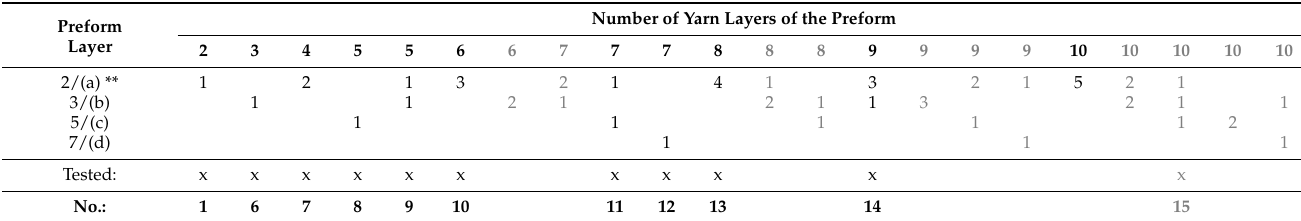
Table 2. Test series numbering and assignment. Table 3. Selection of possible partitioning options in the structure of the fabric samples with 2 to 10 yarn layers. The examined variants are marked with x. The numbering is consecutive for the identification of the respective sample.